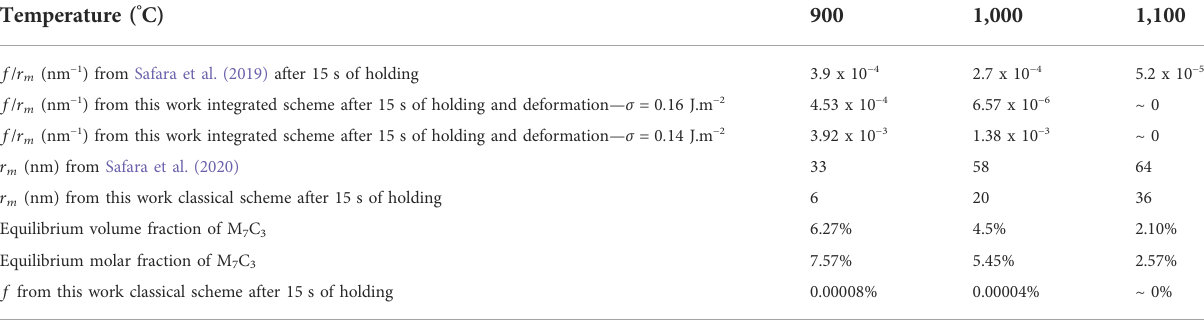
TABLE 2 Ratio of the volume fraction of precipitates over the mean size of precipitates estimated from the experimental work of Safara et al. (2019) and obtained from this work with the integrated modeling tool. Temperature ( °